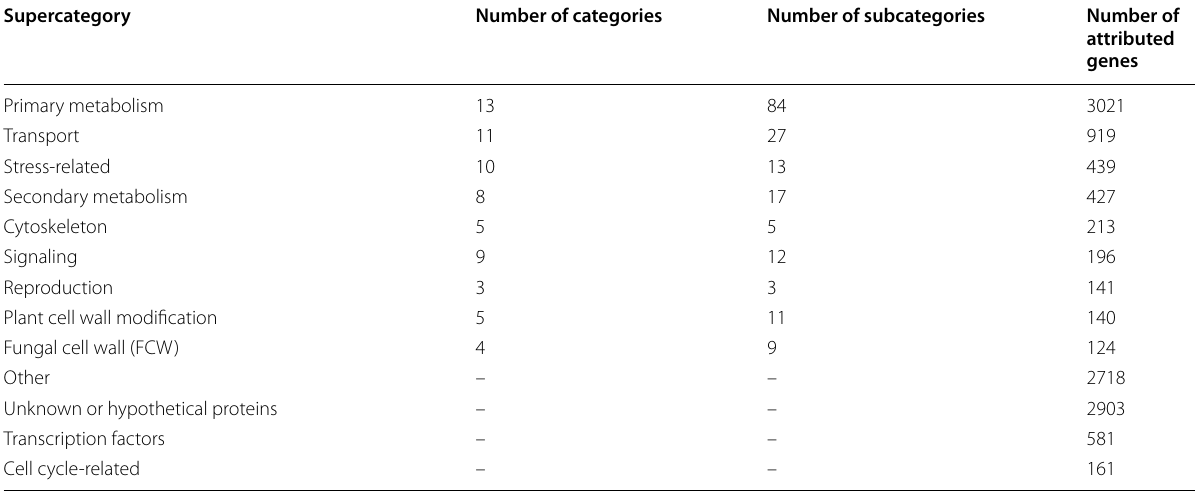
Table 1 Summary of the functional classification of M. nivale genes